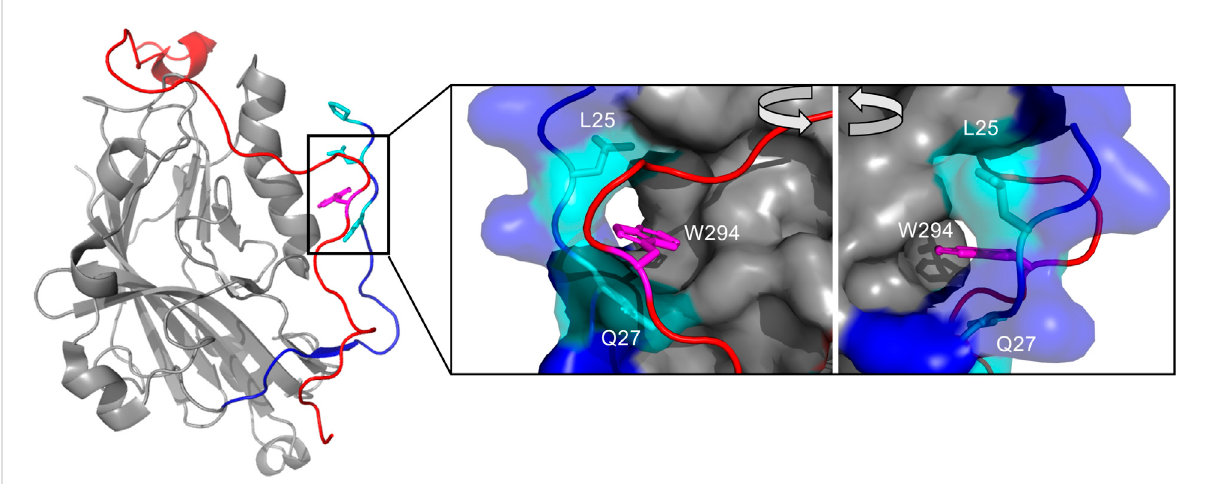
FIGURE 1 The interaction of the N- and C-terminus modulate gD receptor binding, notably the insertion of W294s side chain in the C-terminus into a crevice formed by L25 and Q27 in the N-terminus. Crystal structure of unliganded gD306 307C (2C36), which lacks electron density from 1 – 22 and 257 – 266. The N-terminus (1 – 40) colored in dark blue, with the crevice-forming residues Q27, L25, and P23 colored in cyan with side chains visible. The C-terminus (267 – 306) is colored in red. The insert shows the W294 side chain (magenta) inserted into the crevice formed by Q27 and L25. Visualized and colored with PyMOL Molecular Graphics System, Version 2.0 Schrödinger,